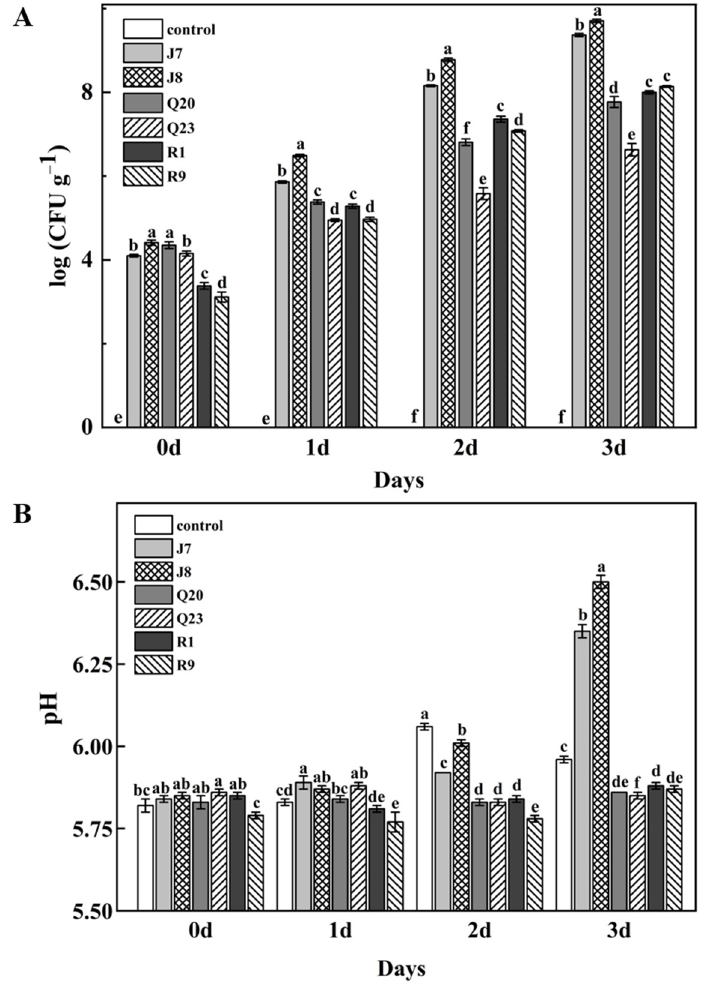
Figure 2. Microbiological growth ( A ) and pH changes ( B ) of chicken breast samples inoculated with P. lundensis J7, P. lundensis J8, A. hydrophila Q20, A. media Q23, B. thermosphacta R1, and B. thermosphacta R9 during storage at 10 °C for three days. Different lowercase letters denote significant differences at different times during storage ( p < 0.05).